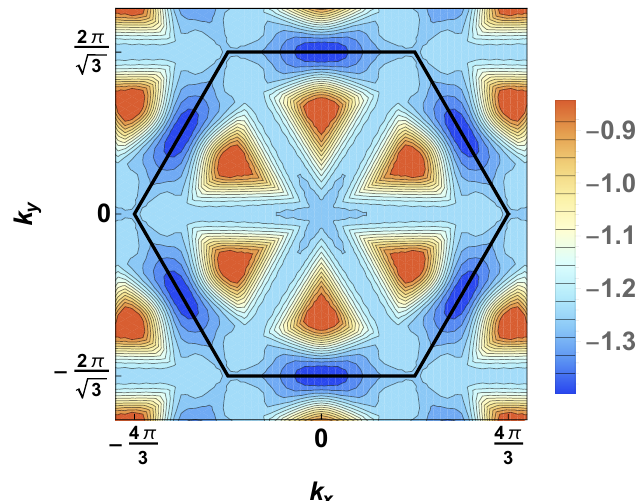
Figure 6: Exact diagonalization result for the dispersion of a single fermionic dimer interacting with a background of bosonic dimers on a lattice of 4 × 4 sites with twisted boundary conditions. Parameters: J = V = 1, t